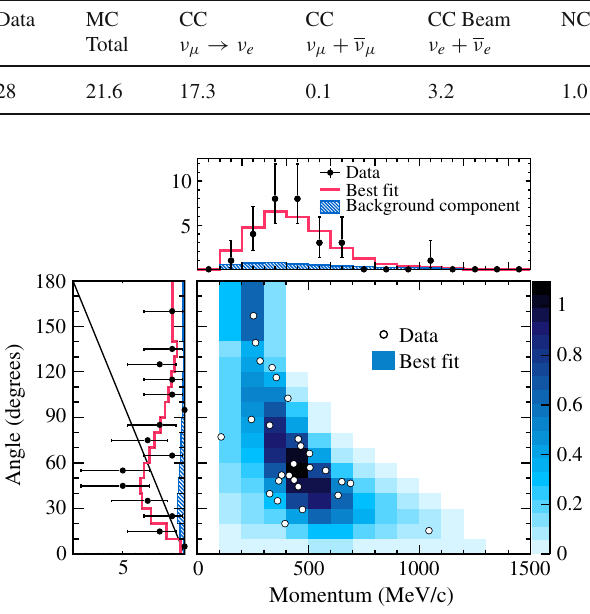
Fig. 57 The electron momentum versus angle distribution for 28 single-ring electron events with the MC expectation in [58]. The best fit value of sin 2 2 θ 13 = 0 . 140 in the normal hierarchy case is used